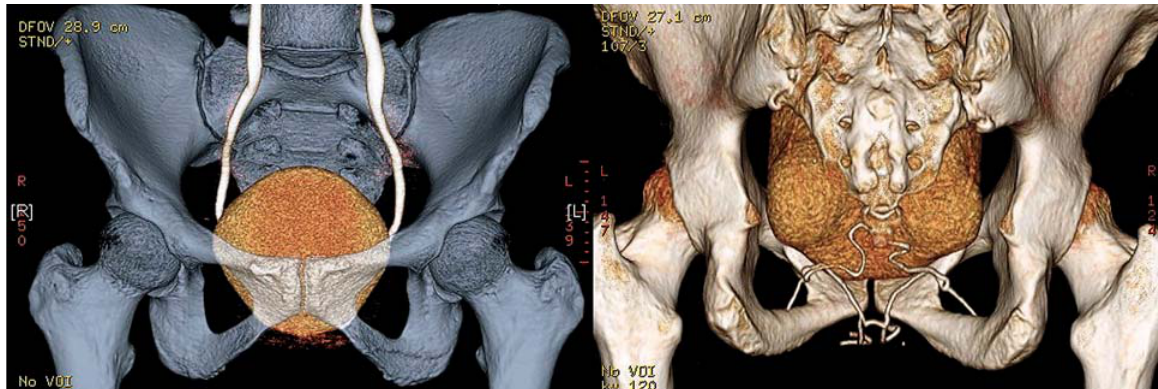
Figure 3 – Pre- and postoperative images of a cystocele corrected using Nazca-TC ® .